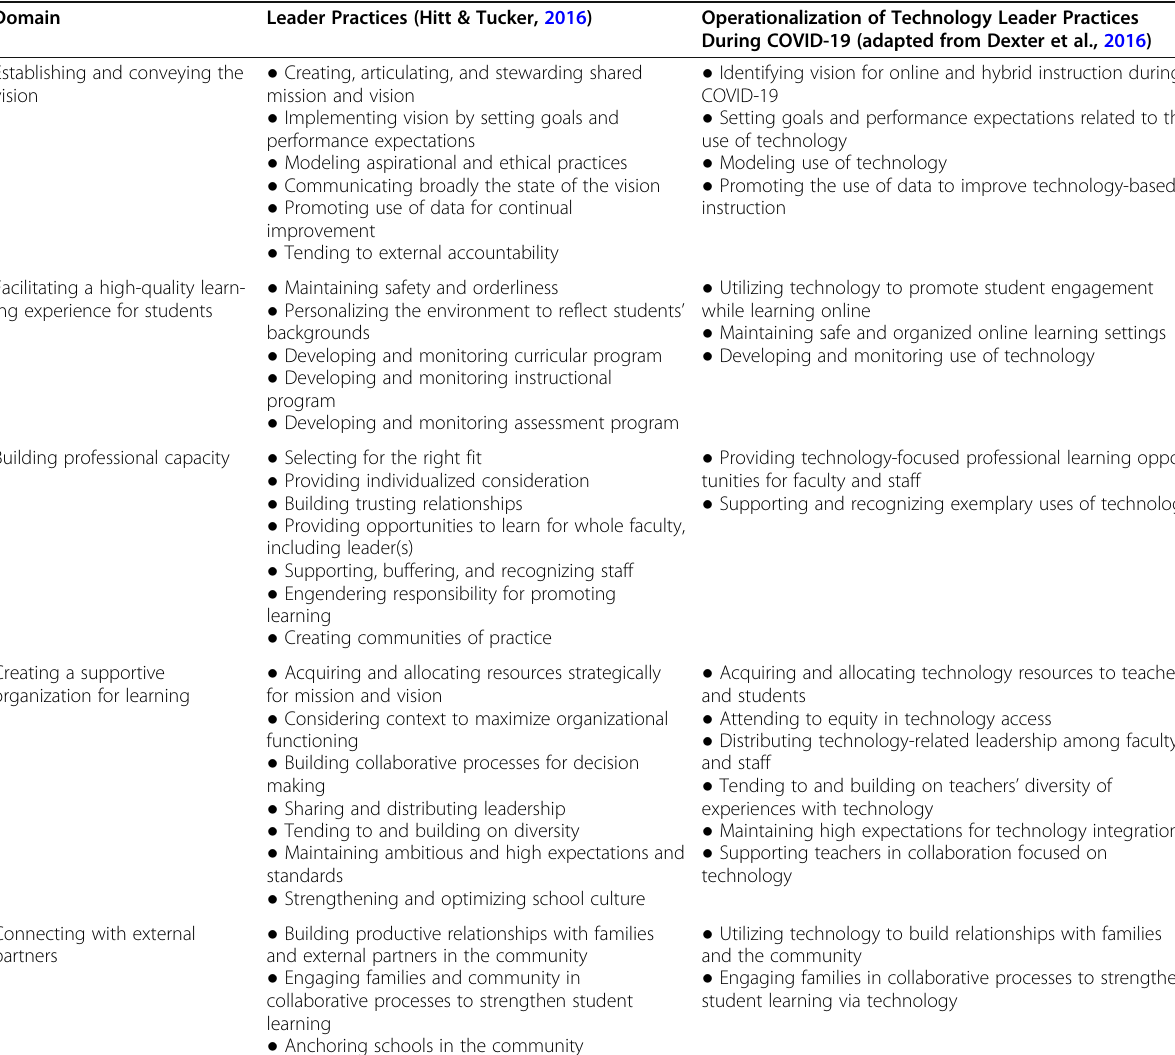
Table 1 Unified model of effective leader practices